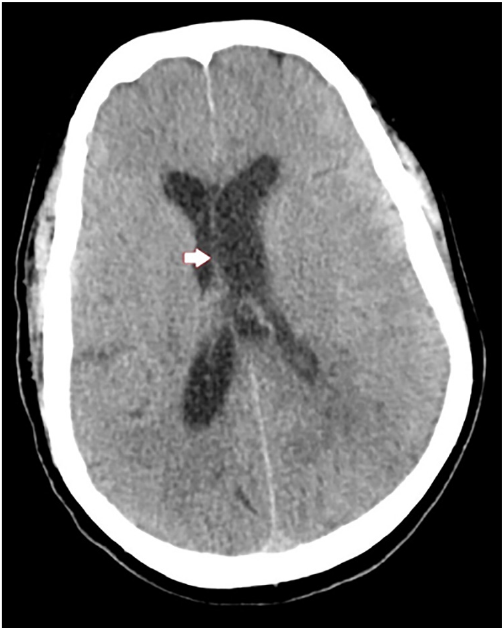
Image 1. Axial computed tomography of the head with intravenous contrast showing mild enlargement of the left lateral ventricle